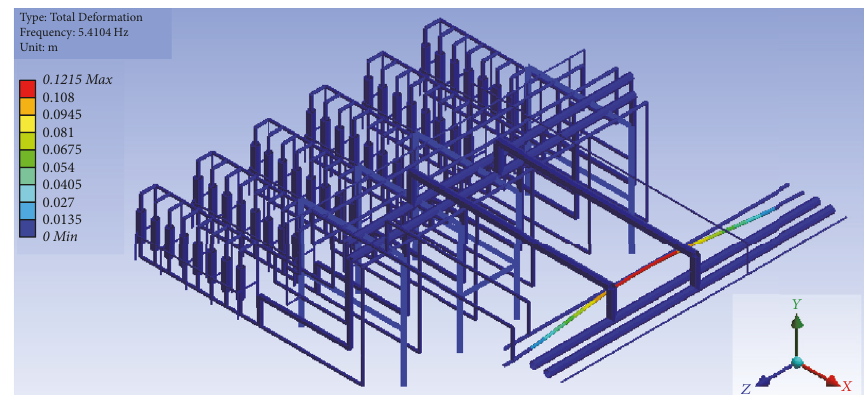
Figure 6: Vibration mode of the 1st modal order.